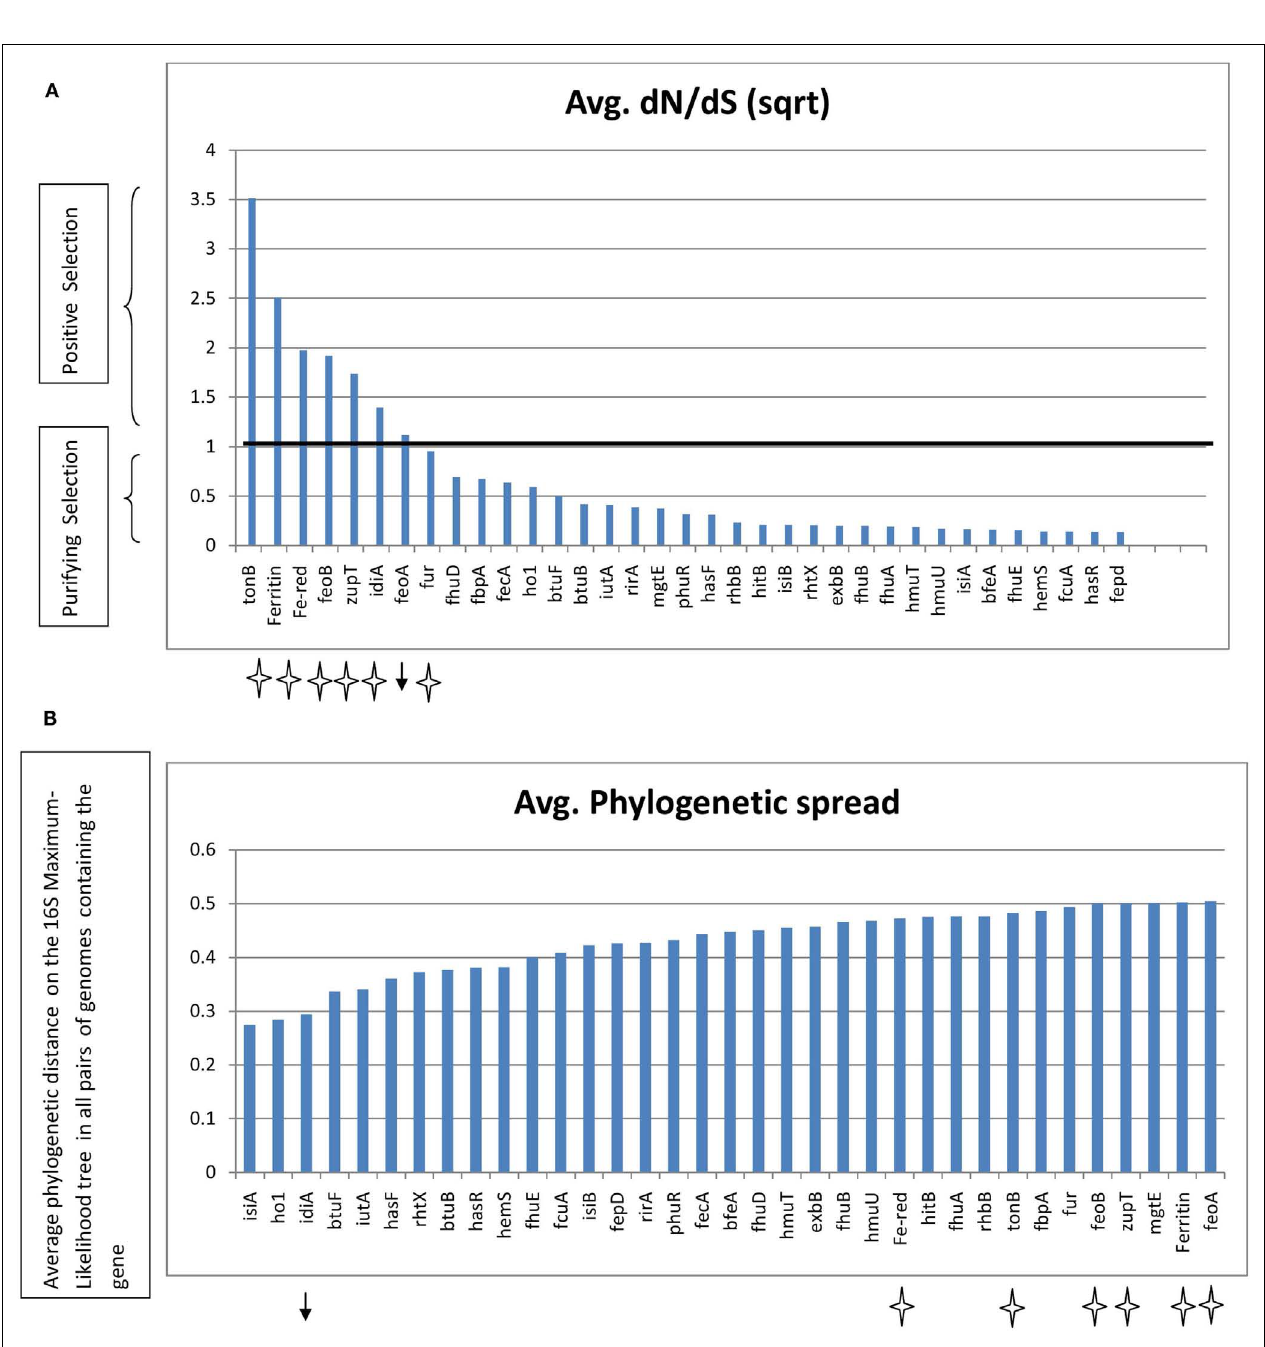
line marks the dN/dS value = 1. Genes with dN/dS > 1 and a wide phylogenetic spread are marked with stars. Genes with dN/dS > 1 and a narrow phylogenetic spread are marked by an arrow. Fe-red – Ferric